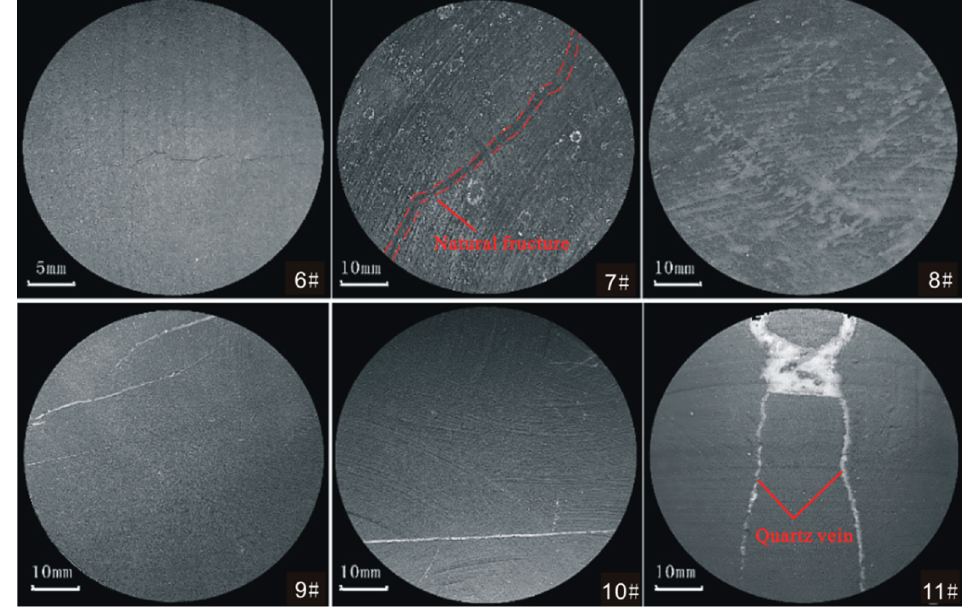
Figure 11. Morphology of shales intrinsic fractures: (6#–8#) carbonaceous shales; (9#–11#) siliceous